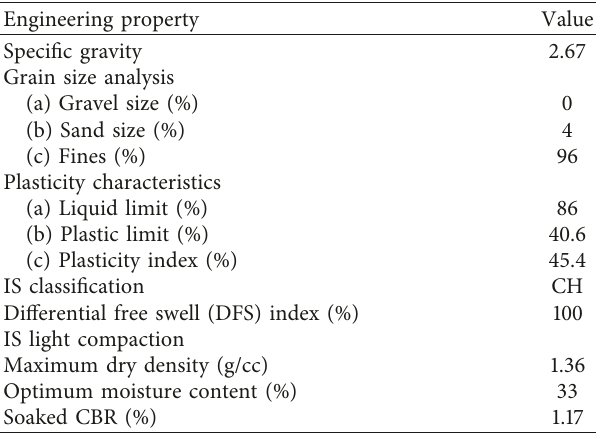
Table 1: Engineering properties of black cotton soil.